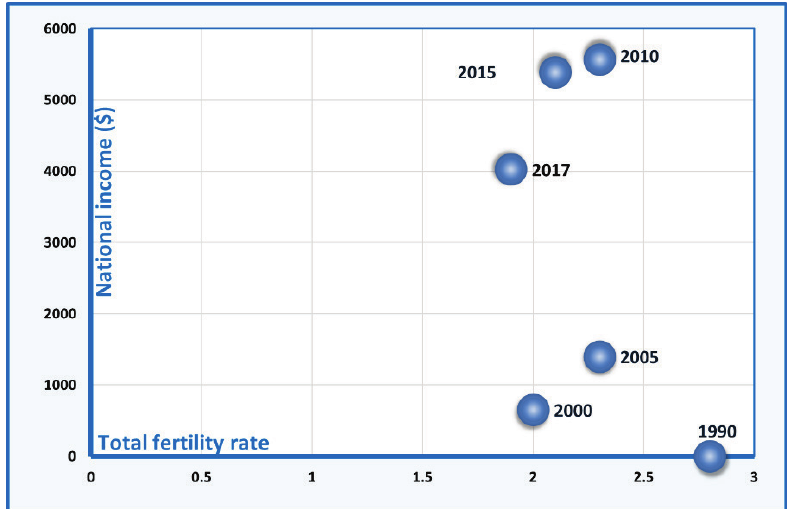
Figure 6. Dynamics of the total fertility rate and national income rate in Azerbaijan. Source: accord- ing to SSC